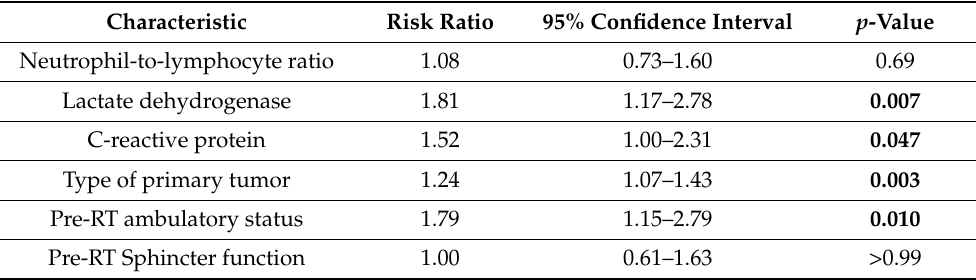
Table 2. Results of the multivariate analysis of